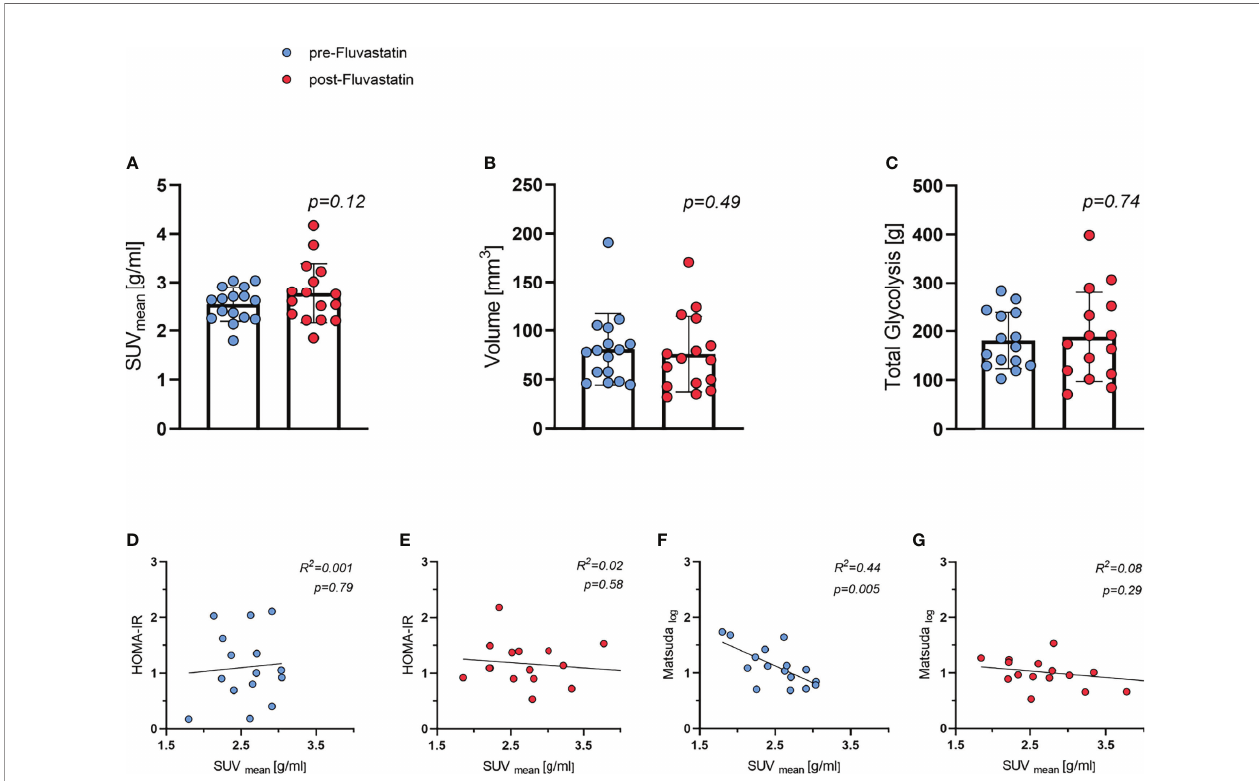
FIGURE 6 | Brown adipose tissue (BAT) activity and relation to insulin sensitivity both before and after two weeks of fl uvastatin treatment. (A) Mean standard uptake value (SUV mean ) p = 0.12. (B) Volume of BAT p = 0.49. (C) Total lesion glycolysis p = 0.74. (D) HOMA-IR and SUV mean before R 2 = 0.001, p = 0.79 and (E) after fl uvastatin intake R 2 = 0.02, p = 0.58. (F) Matsuda and SUV 2 = 0.44, p = 0.005 and (G) after fl uvastatin treatment R 2 = 0.08, p = mean before R